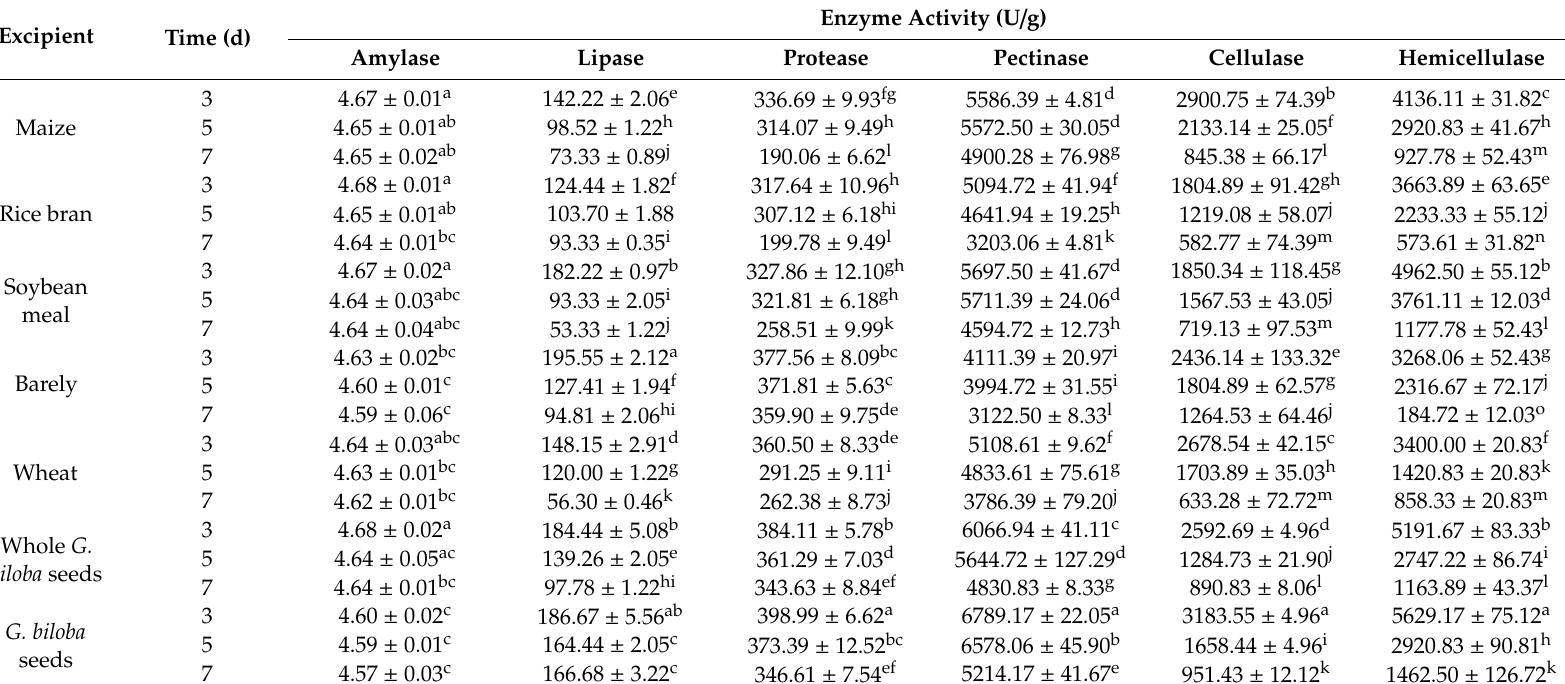
Table 2. E ff ects of the excipients on the activities of several enzymes in fermented G. biloba